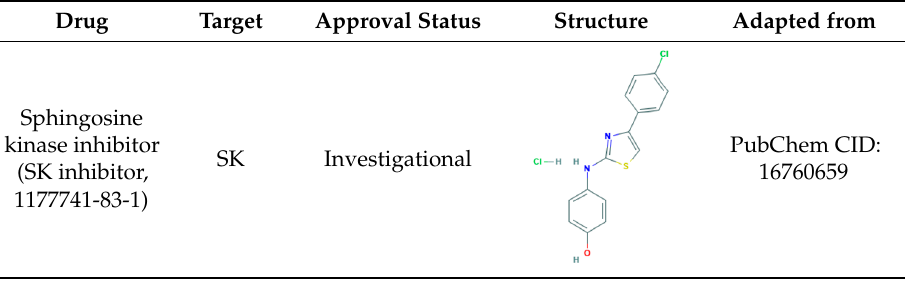
Table 14. Sphingosine kinase inhibitors.